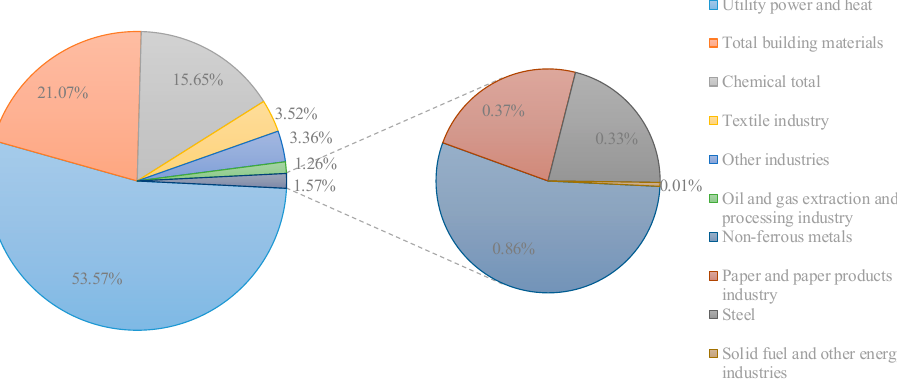
Figure 2. Percentage of energy consumption carbon emissions in Hangzhou.